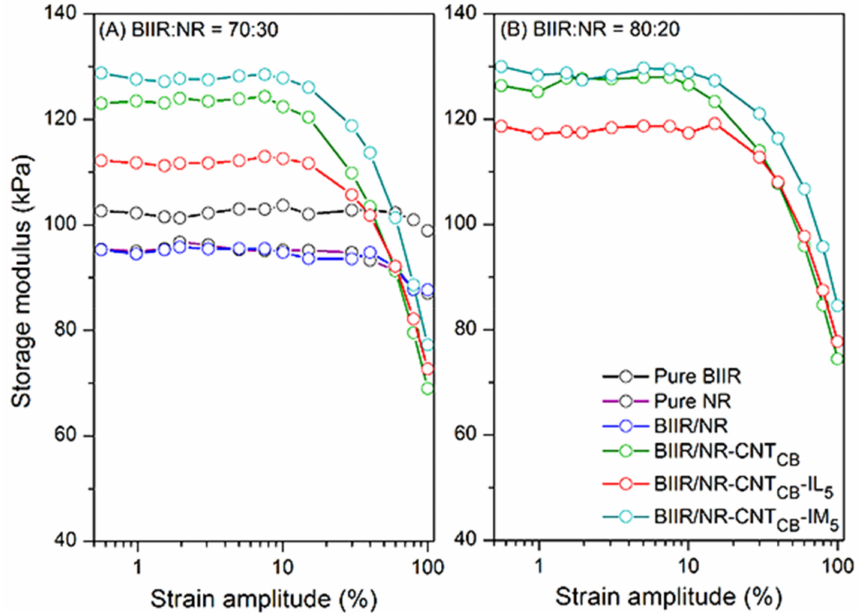
Figure 5. Relation of storage modulus and strain amplitude for pure rubbers and their composites with and without IL and IM modifiers, BIIR:NR ratios of 70:30 ( A ) and 80:20 ( B ).